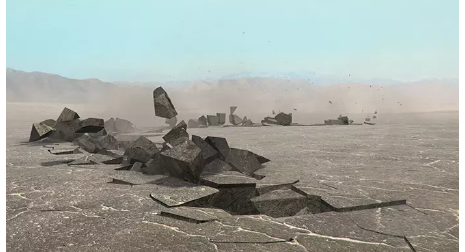
Figure 3. Sample scene from the VR